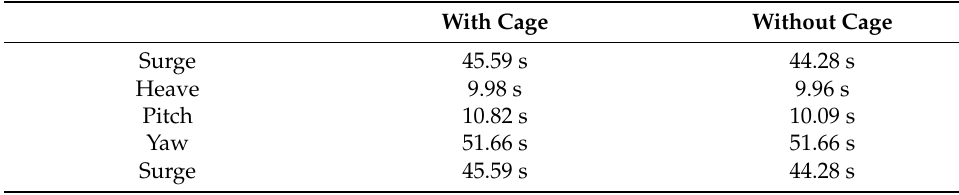
Table 6. The natural periods of the barge-type FOWT-AC and barge-type FOWT. With Cage Without Cage